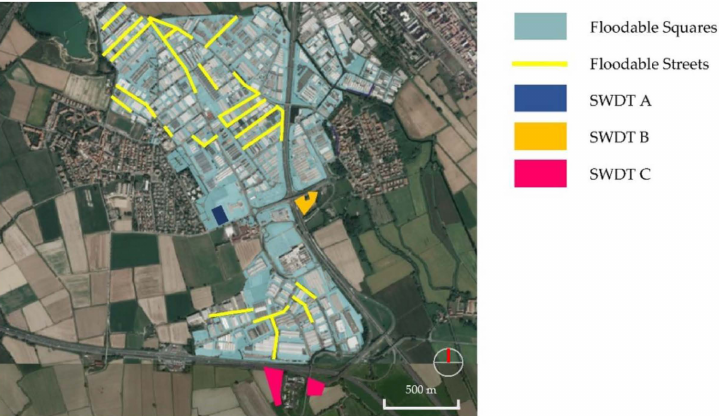
Figure 3. Localization of floodable streets and squares in the diffuse-storage